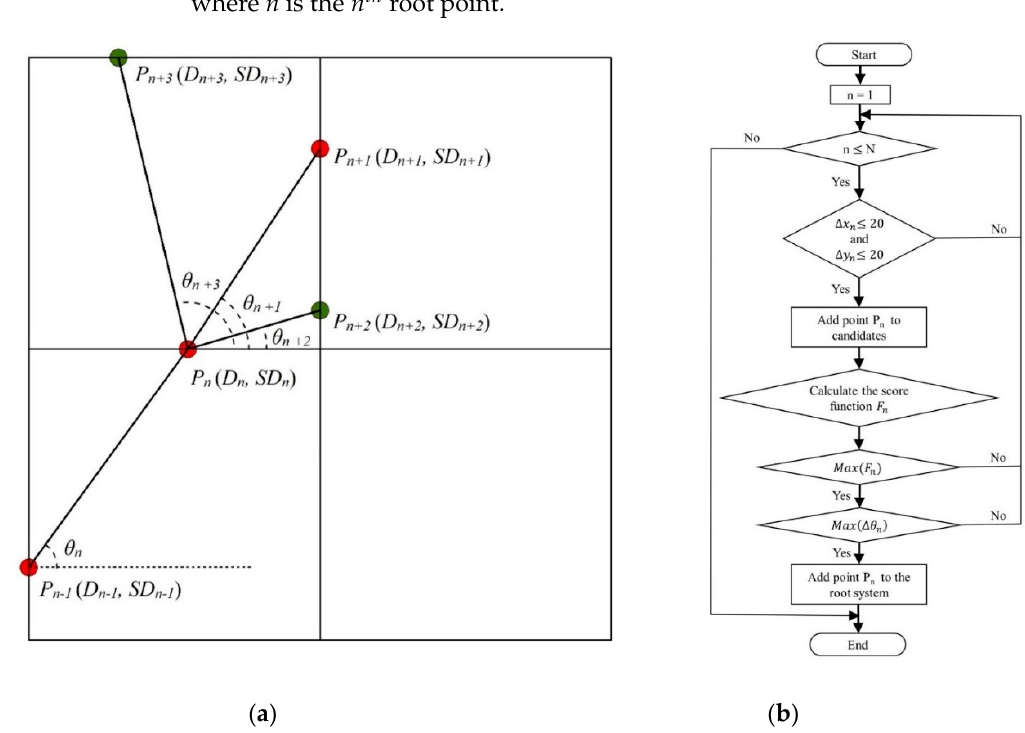
Figure 6. ( a ) Schematic illustration of the principle of connecting root points. Only four interconnected 20 × 20 cm rectangles are shown here. Red points represent the best-connected root points, while green points represent interfering root points; ( b ) flow chart of the root point connection algorithm for the proposed automatic root system architecture (RSA) reconstruction